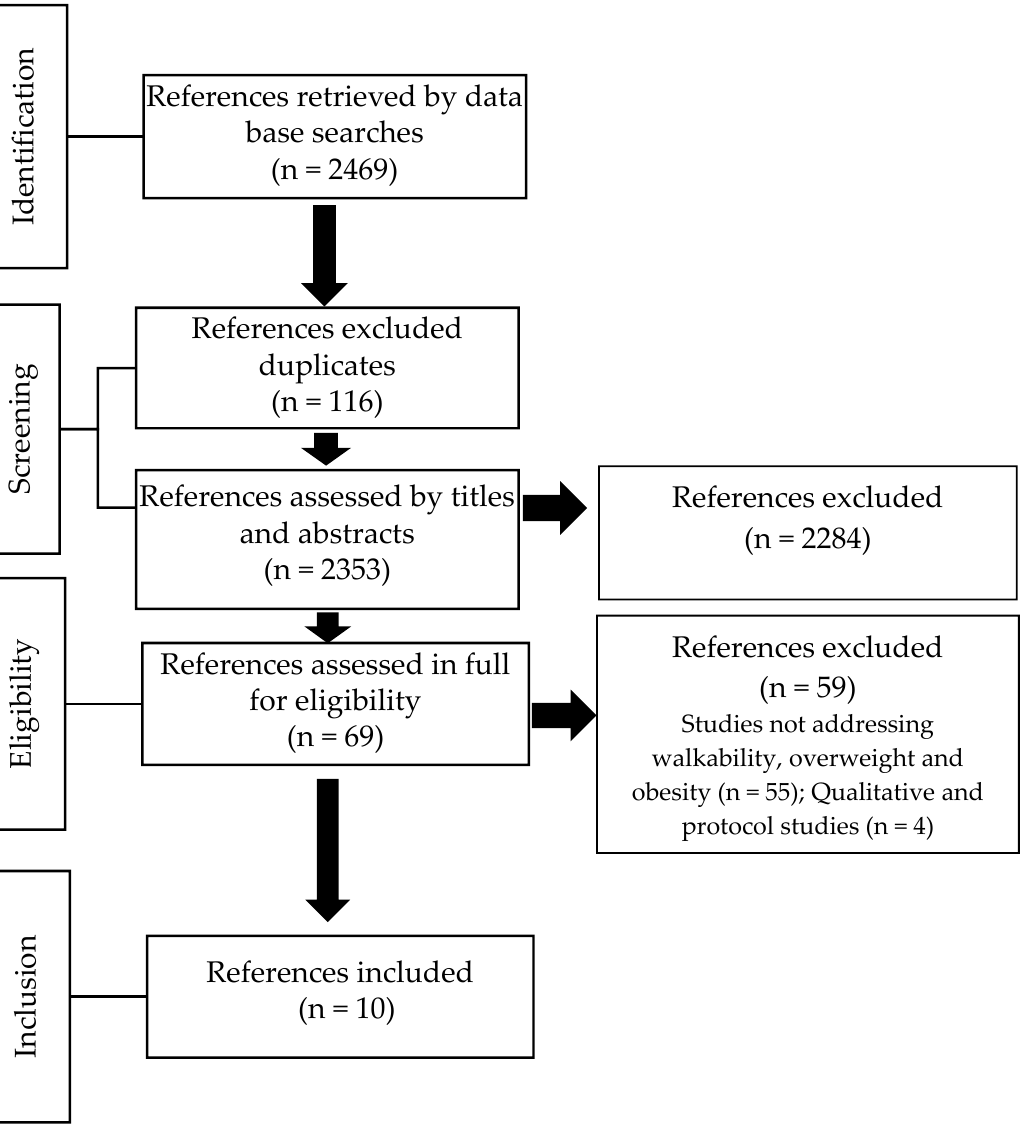
Figure 1. Systematic review flowchart.